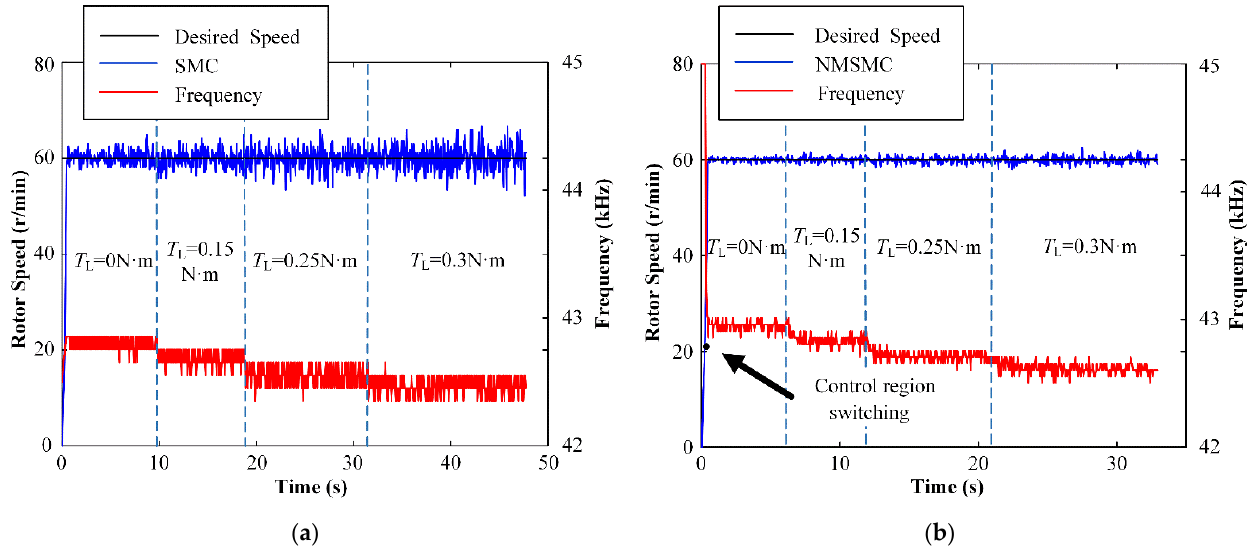
Figure 12. Experiment results of rotor-speed control when the load is applied: ( a ) SMC; ( b )